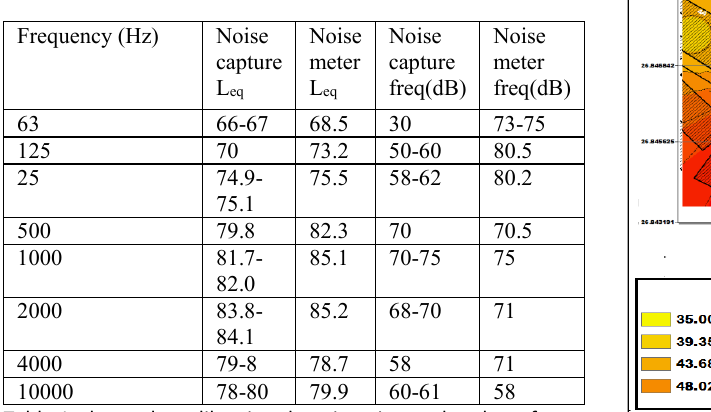
Figure 5. Noise level map of Hazartganj Intersection at morning time using NoiseCapture app scaled with standard